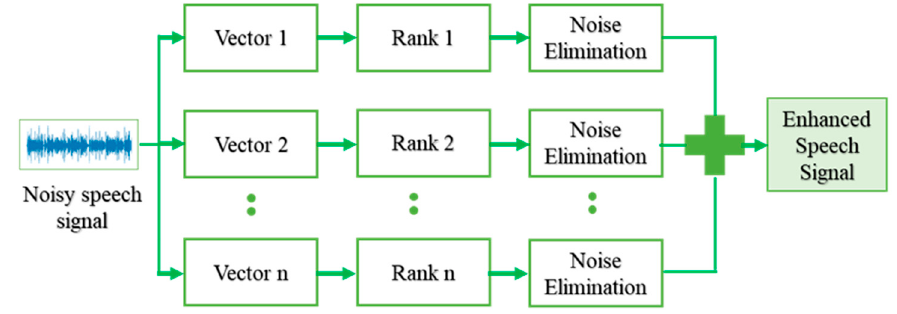
Figure 2. Iterative Signal Enhancement Algorithm.